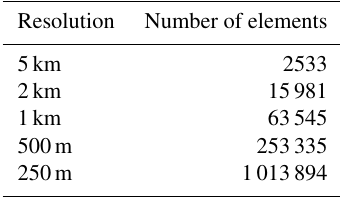
Table 3. Mesh resolution and associated number of